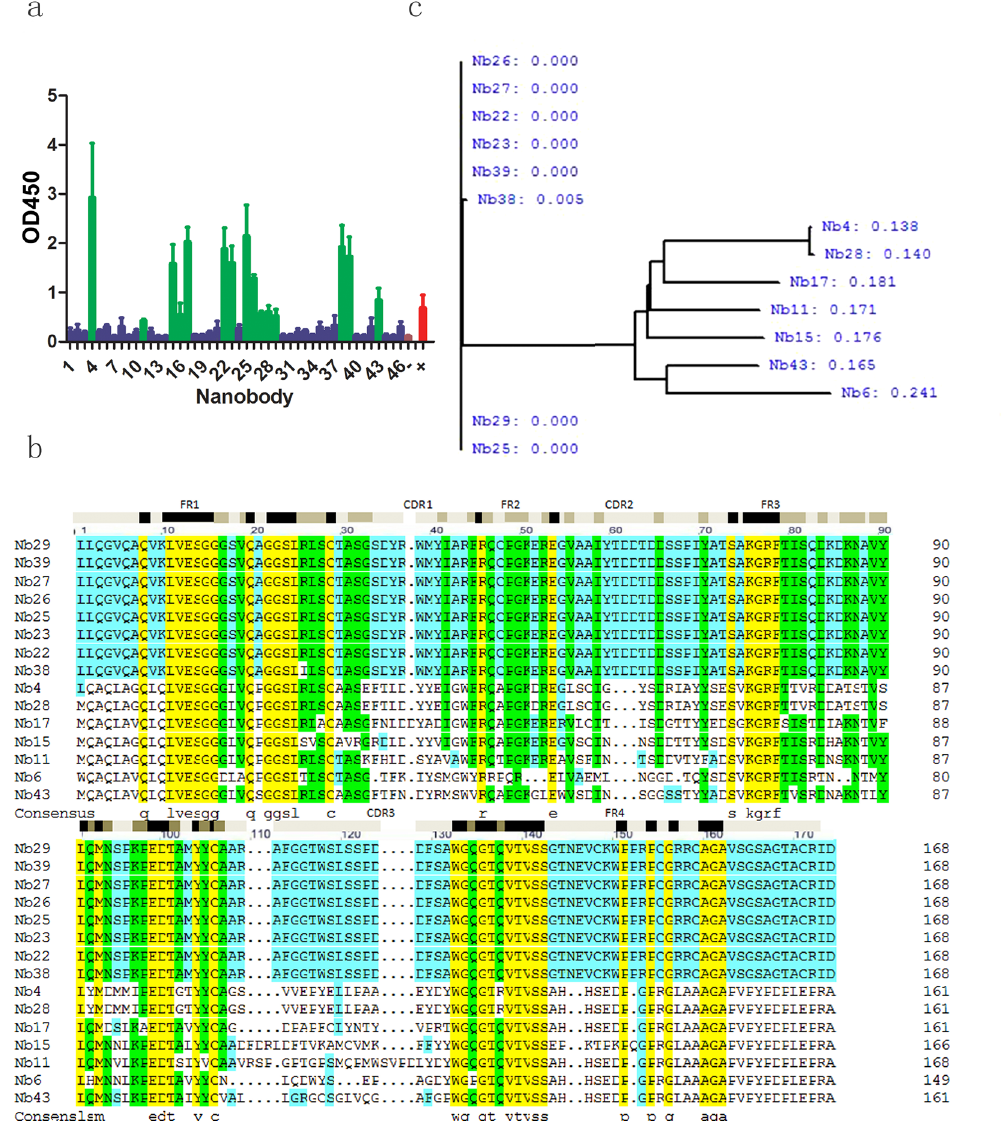
Figure 2. Identification of nanobody that specifically bound to human lung SP-A protein. ( a ) A total of 15 positive monoclonal Nbs were identified. ( b ) Peptide sequencing analysis revealed 4 IgG2a subtype clones and 11 IgG3 subtype clones. ( c ) Cluster analysis of the 15 peptide sequences found 7 different sequences and 2 overlapping sequences (Nb4 and Nb28). Phage-ELISA assay was performed using human pulmonary tissue total protein extracts as the antigen source and SP-A-mAb as the primary